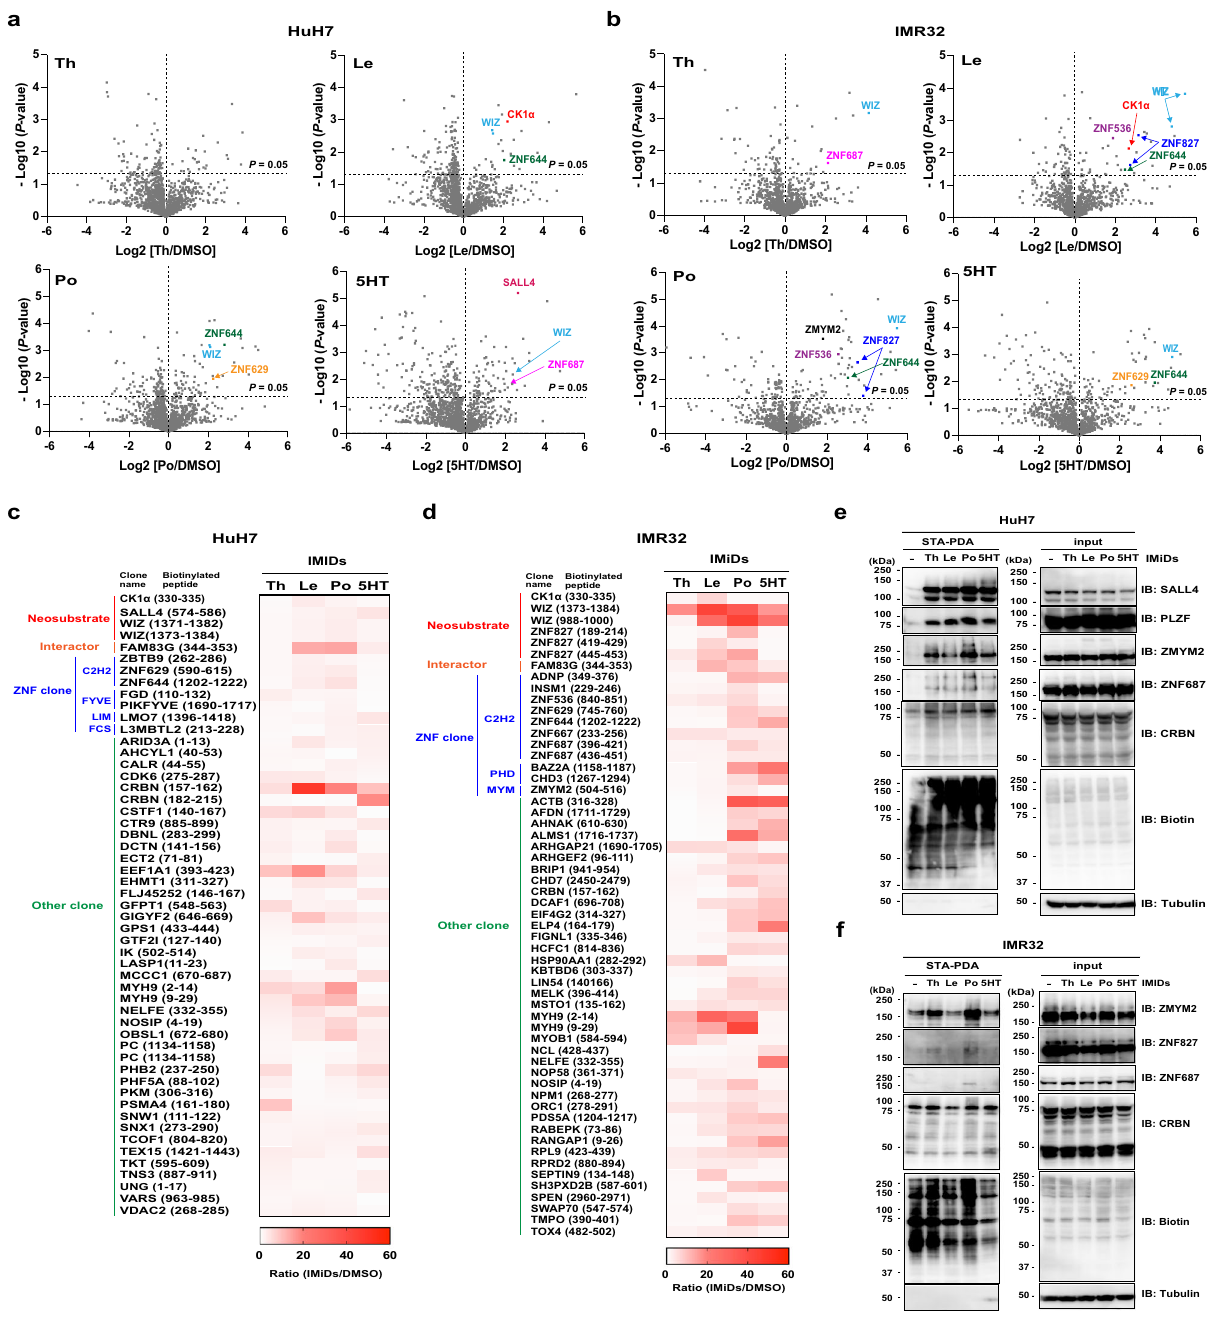
Fig. 3 Biotin-dependent LS-MS/MS analyses using HuH7 and IMR32 cells expressing AirID-CRBN. a , b LC-MS/MS analysis of biotinylated peptide using AirID-CRBN for ( a ) HuH7 or ( b ) IMR32 cells. HuH7 or IMR32 cells stably expressing AGIA-AirID-CRBN-WT were treated with DMSO, 20 µ M thalidomide (Th), 10 µ M lenalidomide (Le), 10 µ M pomalidomide (Po) or 20 µ M 5-hydroxythalidomide (5HT) in the presence of 10 µ M biotin and 5 µ M MG132 for 8 h (biological replicates; n = 3). c , d Heat map of biotinylated peptides (IMiDs/DMSO ratio >3 and P -value <0.05) in c HuH7, or d IMR32 cells detected by LC-MS/MS analysis. a – d Signi fi cant changes in the volcano plots and heat maps were calculated by Student ’ s two-sided t -test and the false discovery rate (FDR)-adjusted P -values calculated using Benjamini – Hochberg method are shown in the Supplementary Data 7, 8. e , f IMiDs-dependent biotinylation assay of neo-substrate candidates detected by LC-MS/MS analyses in e HuH7 or f IMR32 cells. HuH7 or IMR32 cells stably expressing AGIA- AirID-CRBN-WT were treated with DMSO, 20 µ M thalidomide (Th), 10 µ M lenalidomide (Le), 10 µ M pomalidomide (Po) or 20 µ M 5-hydroxythalidomide (5HT) in the presence of 10 µ M biotin and 5 µ M MG132 for 8 h. Then, the biotinylated proteins were pulled down using streptavidin beads and analysed by immunoblotting. The experiments were repeated twice independently with similar results. Source data are provided as a Source data fi